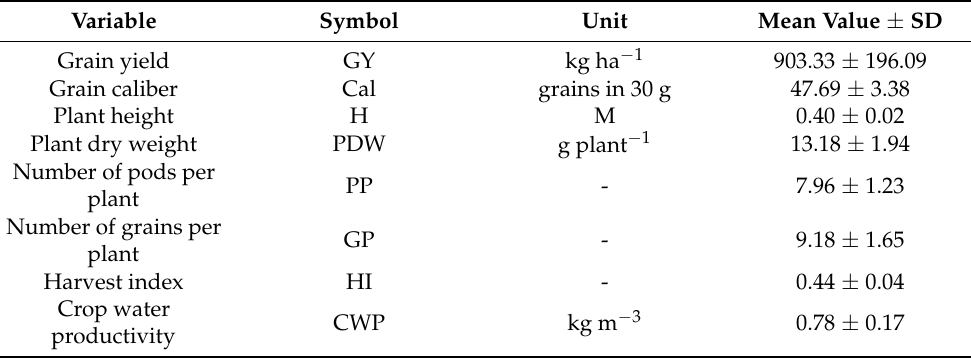
Table 5. Response variables of chickpea deficit irrigation experiments during two consecutive years (2020 and 2021) at Todos Santos, Baja California Sur,